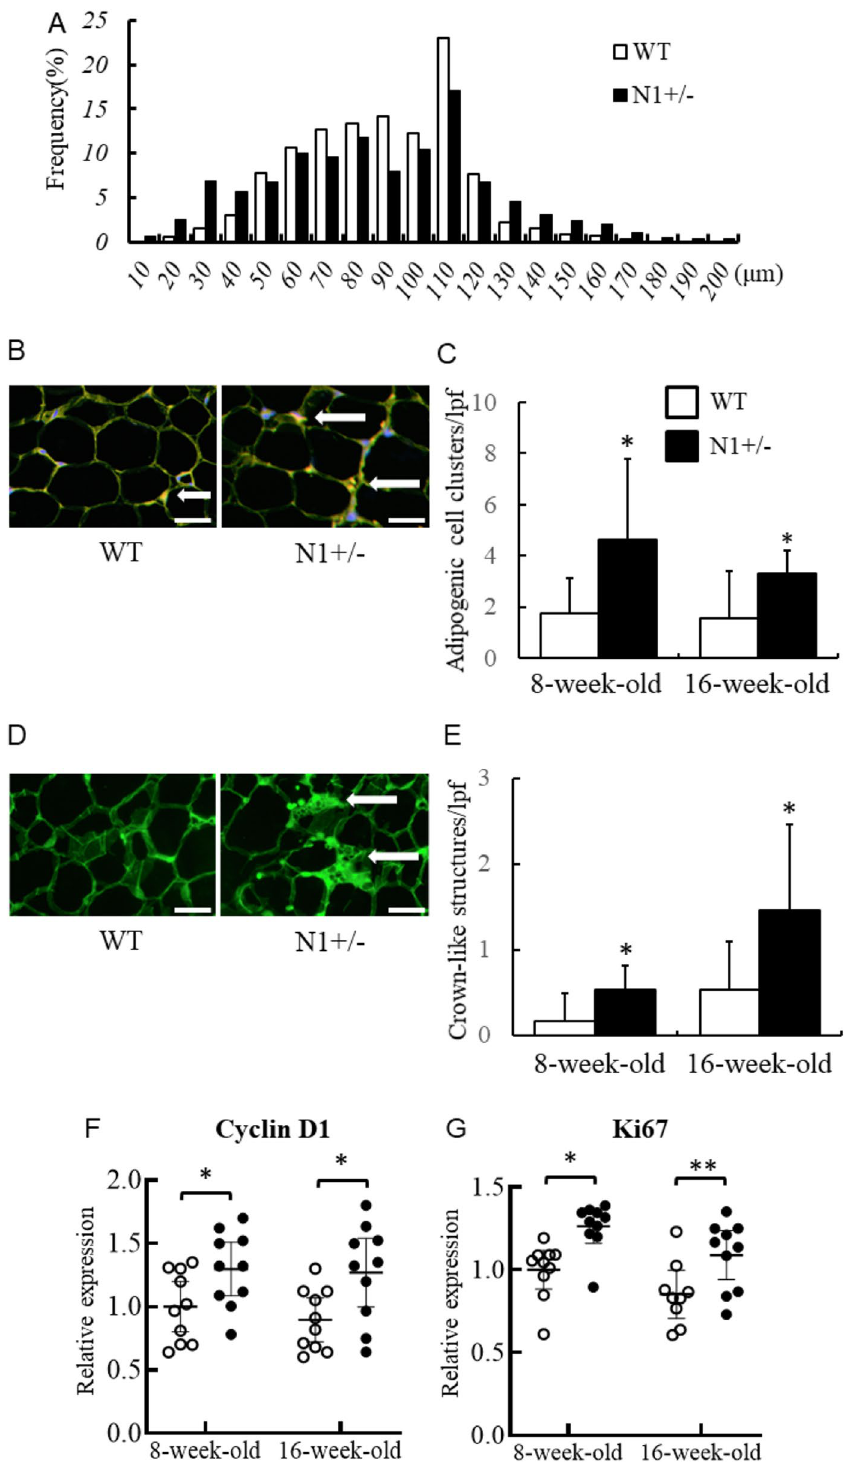
Figure 2. Notch1 haploinsufficiency reveals adipogenic property. Abundance of small- and large-diameter adipocytes in inguinal adipose tissue of N1+/− mice. Adipogenic cell clusters (CD34+CD68+ cells), crown-like structures (MAC-2-positive multinuclear giant cells surrounding individual adipocytes), and quantitative PCR for proliferation markers (cyclin D1 and Ki67) were increased in N1+/− mice. ( A ) Distribution of adipocyte cell diameter in inguinal adipose tissues of WT and N1+/− mice after 12-week HF/HS diet. ( B ) Immunohistochemical analysis of adipogenic cell clusters in adipose tissue of 8-week- old WT and N1+/− mice (arrows). Scale bars = 20 μm. ( C ) The percentage of adipogenic cell clusters was higher in HF/HS diet-fed N1+/− mice. ( D ) Immunohistochemical analysis of crown-like structures in adipose tissue of 8-week-old WT and N1+/− mice (arrows). Scale bars = 20 μm. ( E ) The density of crown-like structures was higher in HF/HS diet-fed N1+/− mice. ( F ) Quantitative analysis of cyclin D1 mRNA in adipose tissue of WT and N1+/− mice, fed with HF/HS diet. ( G ) Quantitative analysis of Ki67 mRNA in adipose tissue of WT and N1+/− mice, fed with HF/HS diet. Data are mean ± SD. *P < 0.05 and **P < 0.01, compared with WT mice. n = 8–10 per